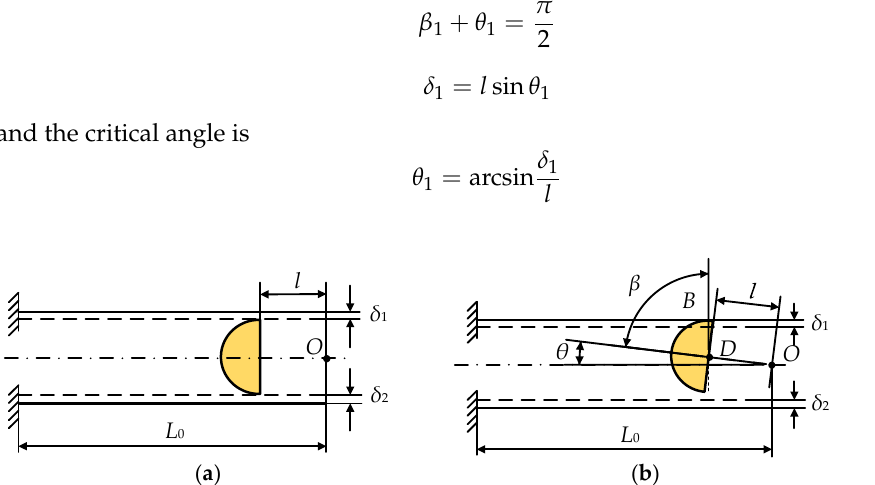
Figure 11. Stiffness curve near the initial state under different values of R .